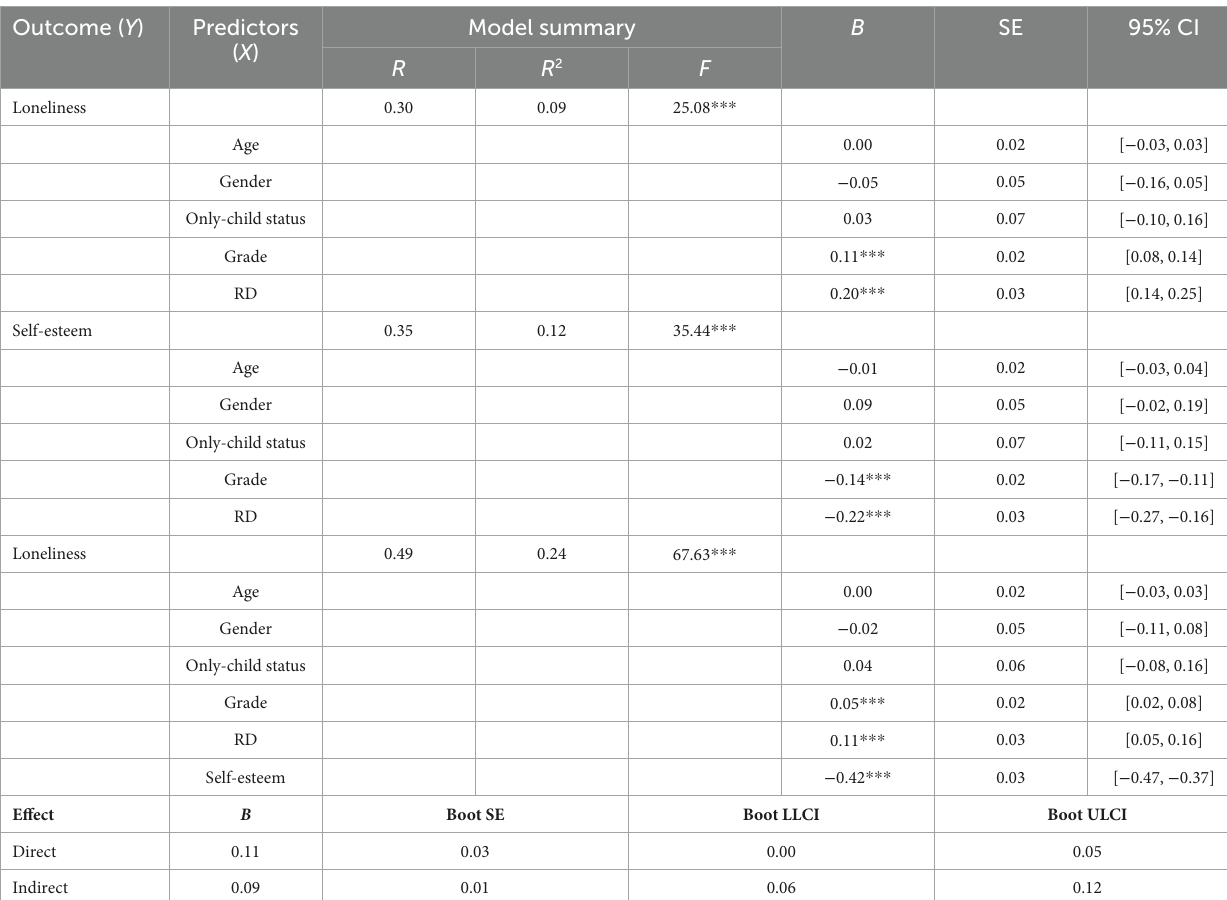
TABLE 3 Testing the mediation effect of